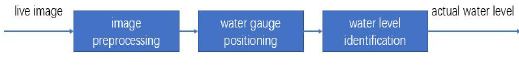
Figure 4 . Flowchart of water level identification